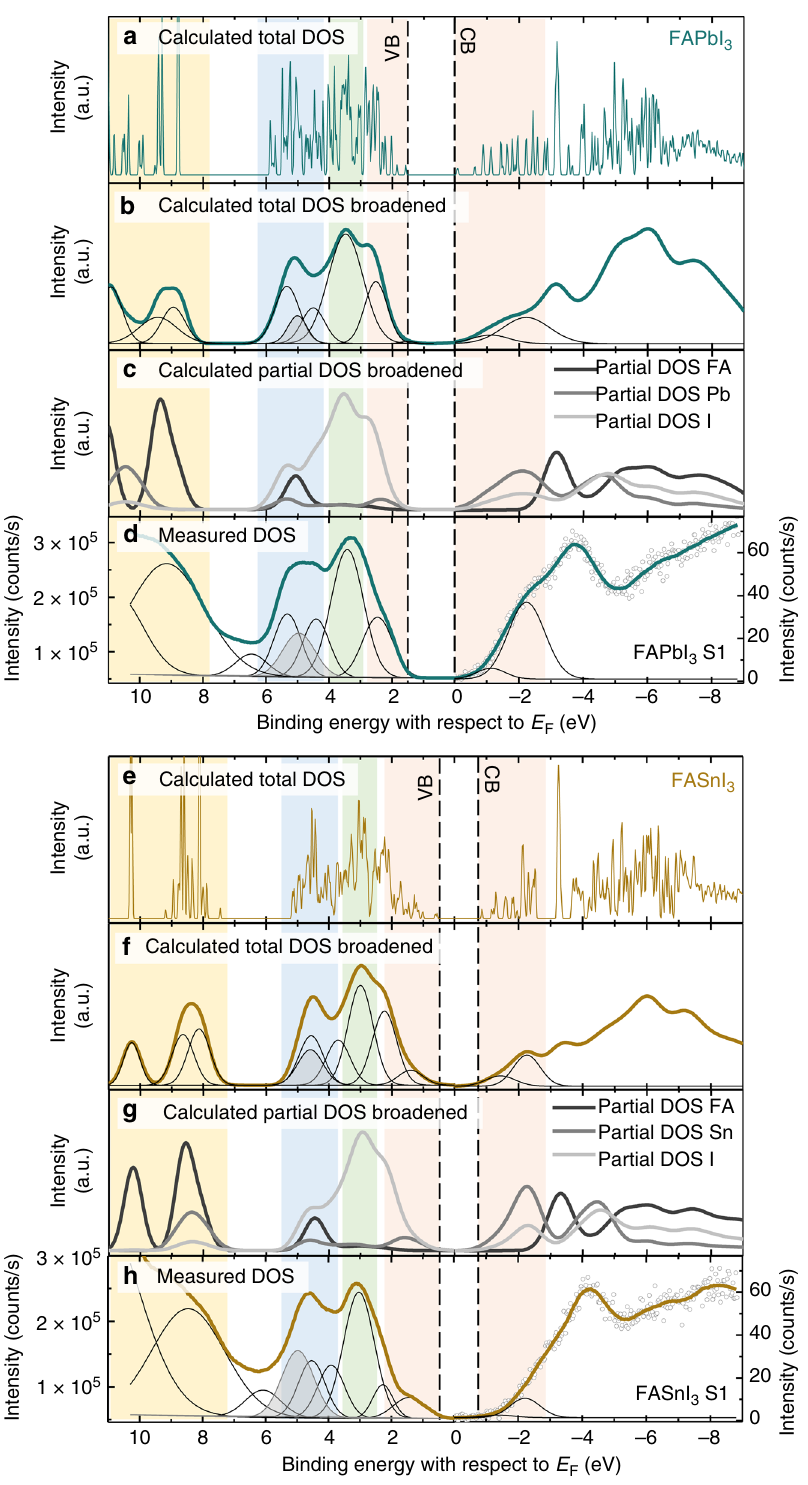
Fig. 2 Comparisons between measured and DFT-calculated densities of states. a Calculated DOS of FAPbI 3 . b Same DOS uniformly broadened by a Gaussian function and subsequently this broadened DOS is fi tted with Gaussian peaks. c Similarly broadened DOS, but showing the partial DOS contributions of the perovskites constituents. d Experimental DOS of FAPbI 3 , measured by UPS and IPES, fi tted with a similar set of Gaussian peaks, so that the DFT and experimental spectra can be aligned. Sub fi gures e to h show the equivalent plots for FASnI 3 . The different colored vertical bars act as guide for the eye to show how the spectra are lined up while the dashed lines show the onset of the VB and CB in the unbroadened DFT data; the shaded gray peak corresponds to FA related features. Note that the x-axes are plotted with respect to the Fermi level and the DFT spectra have been shifted to match their Fermi energies of the measured data sets. Further, the DFT data are plotted (in accordance with the measurement) using positive energies for VB and negative energies for CB bands; in Figs. 3 and 4 we use opposite signs for the energies, in agreement with standard DFT